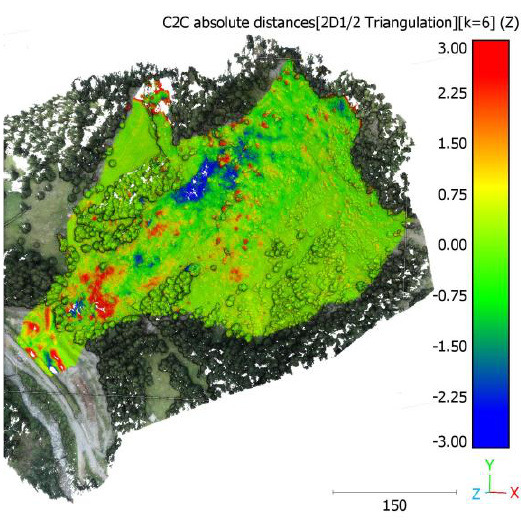
Figure 14. 2019-2020 cloud difference in